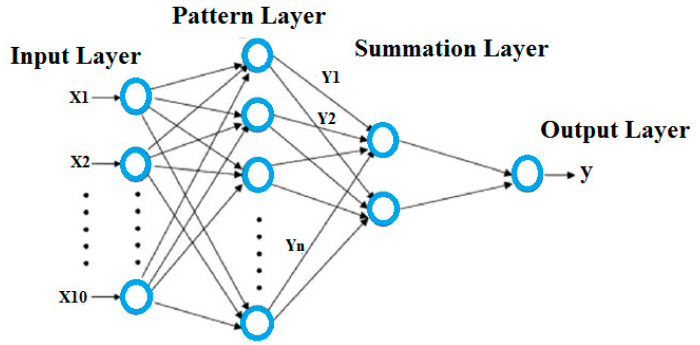
Figure 4. The architecture of the GRNN model.